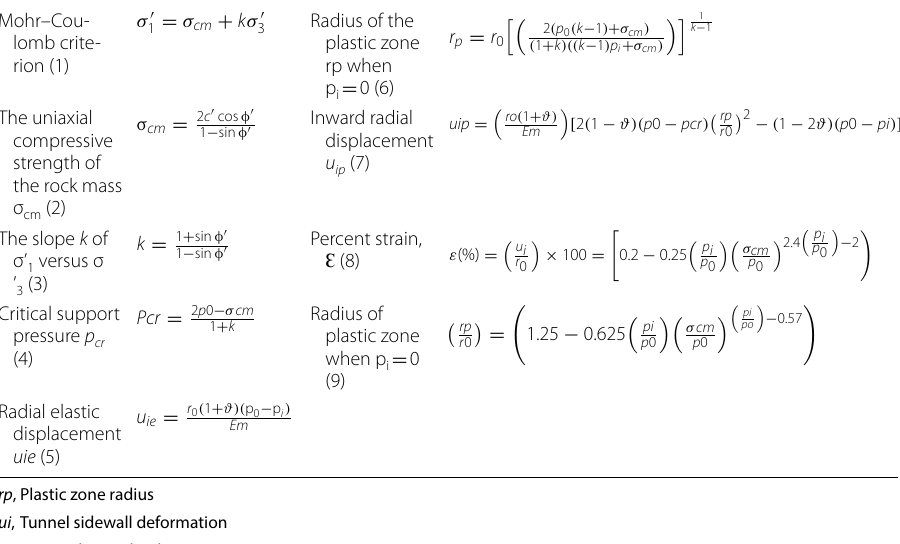
Table 2 Closed-form solution equations [44–46]